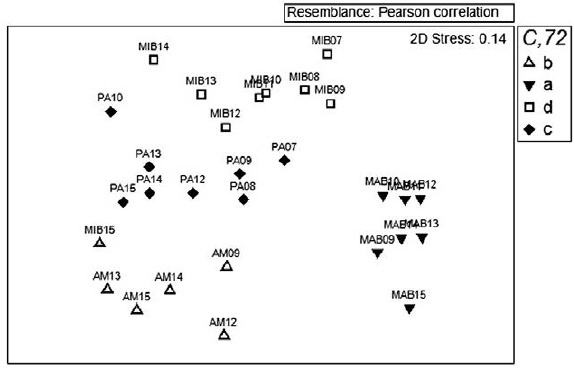
Fig. 4. – 2-d nMDS ordination plot for the 29 contests. Superim- posed symbols for the different